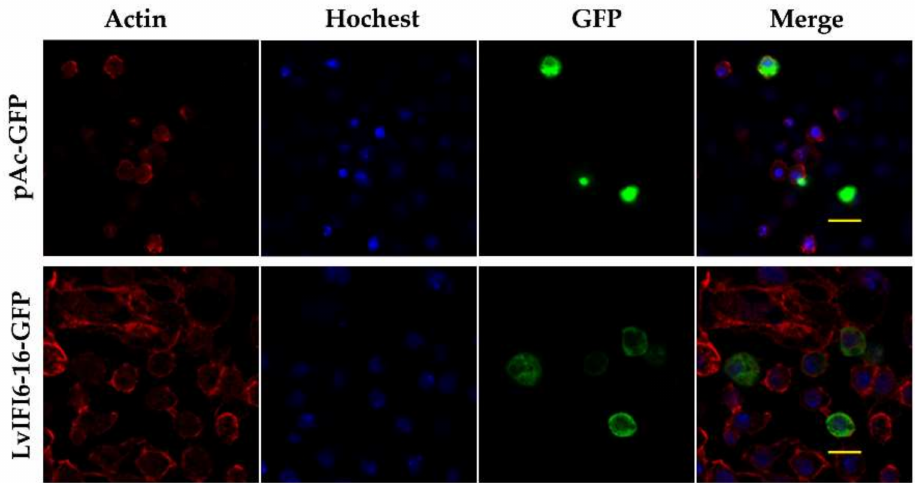
Figure 3. Subcellular localization of LvIFI6-16 in Drosophila S2 cells. Scale bar, 20 µ